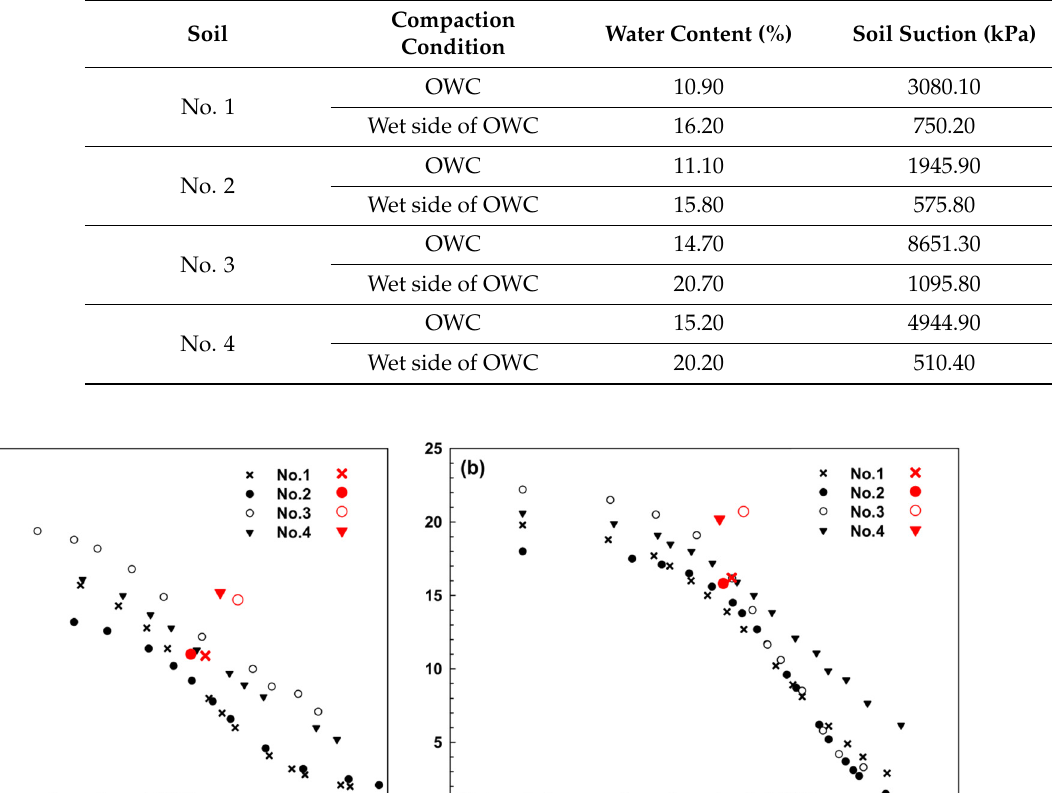
Table 3. Matric suction values at compacting water content for compacted samples.